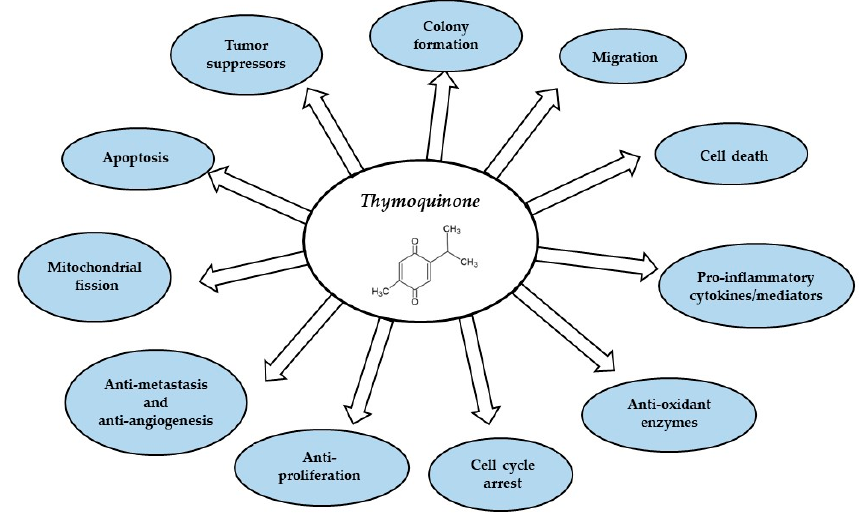
Figure 2. Thymoquinone targets different sites in inflammatory diseases and cancer.